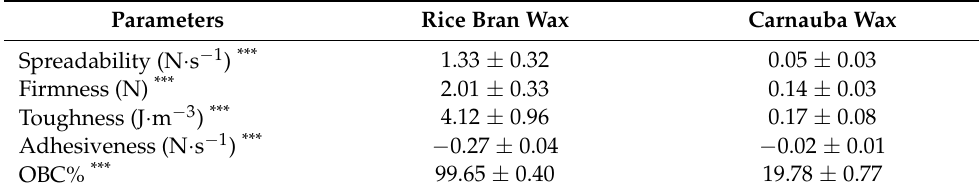
Table 2. Texture and oil binding capacity of oleogels (Mean ±